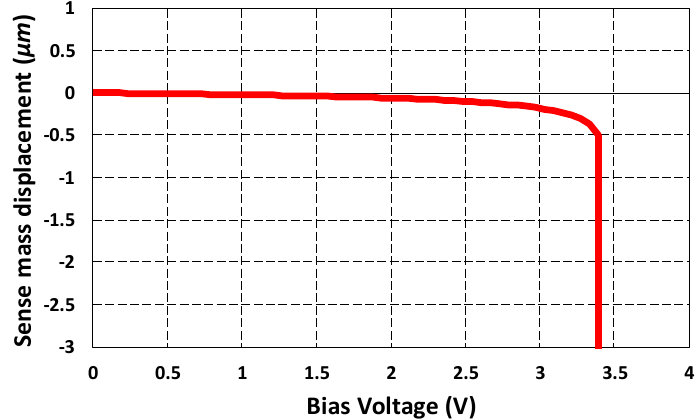
Figure 8. Sense mass displacement vs. applied bias voltage graph for the MEMS gyroscope.